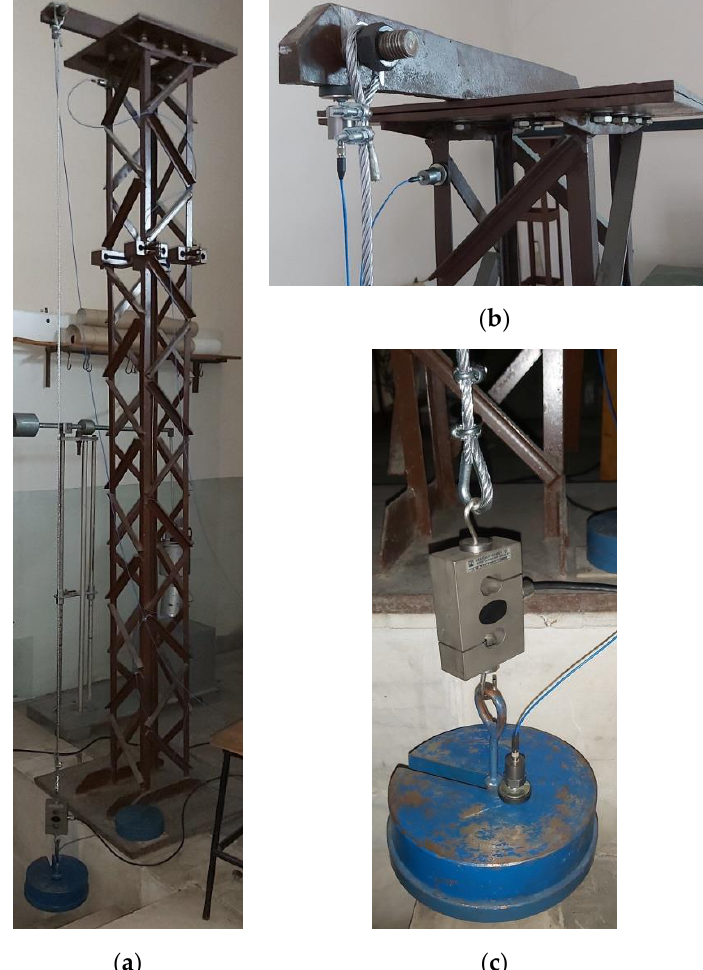
Figure 1. The experimental setup: ( a ) full view of laboratory stand; ( b ) detail view of rigid tower upper side device for hanging the wire rope, with parasite motions monitoring transducers; and ( c ) detailed view of loading mass ensemble, with force and acceleration transducers.